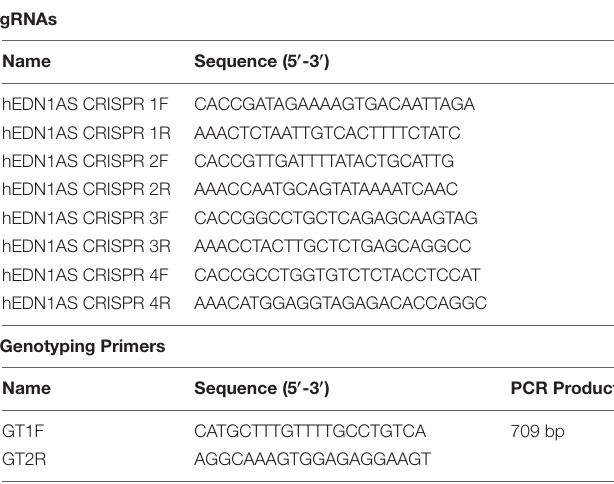
TABLE 2 | Guide RNAs for CRISPR/Cas9 and genotyping